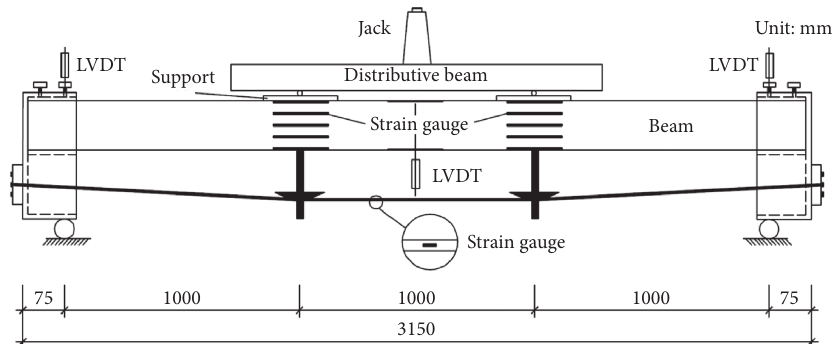
Figure 2: Loading mechanism of the prestressed glulam beam and layout of the strain gauge.